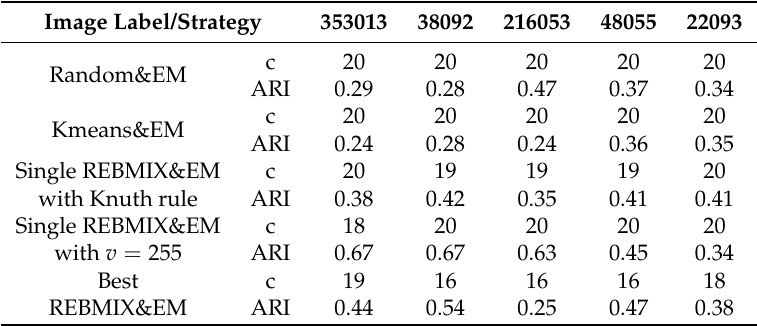
Figure 9. Showcase segmentation of flower image (label 353013 ) and herd image (label 38092 . The first row is ground-truth segmentations; Second row: Segmentation using random colors for each component in estimated GMM; Third row: Segmentations using mean values of the components in the estimated GMM. Table 3. Numerical results of image segmentation